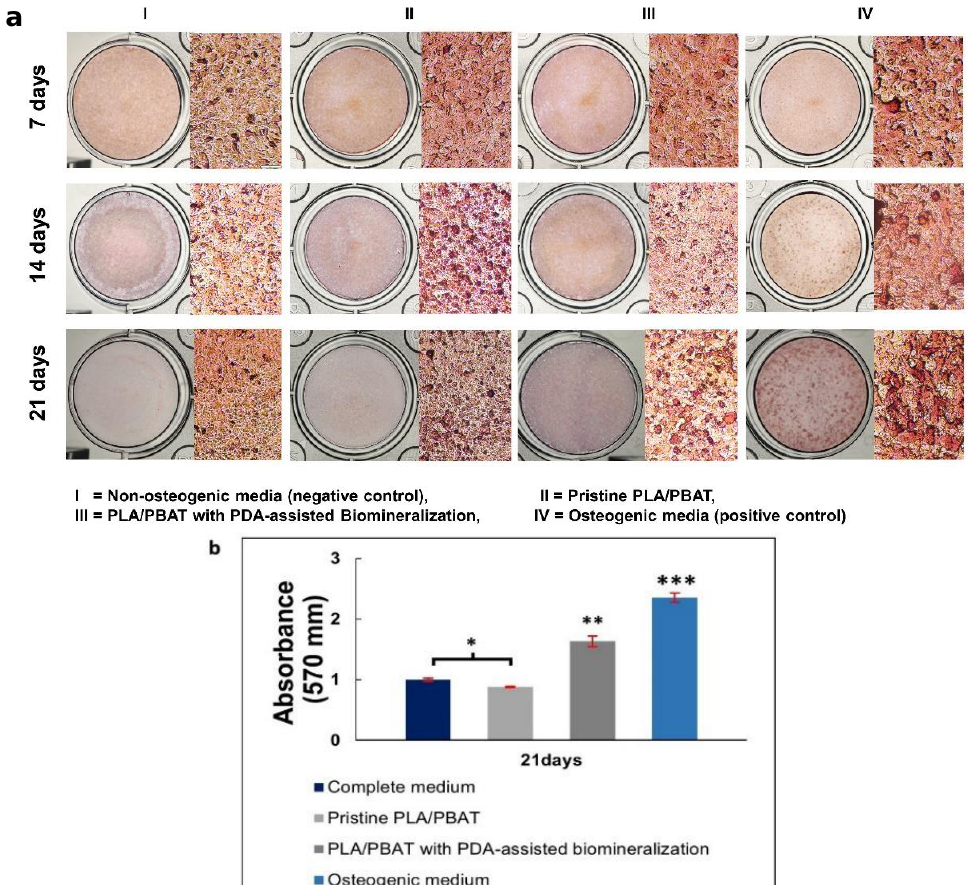
Figure 13. Mineralization assay with Alizarin Red S staining of MG-63 cells. Images of MG-63 cells cultured in the complete medium (negative control), extraction medium of pristine PLA/PBAT, extraction medium of PLA/PBAT with PDA-assisted biomineralization, and the osteogenic media (positive control) for 7, 14, and 21 days ( a ). Quantitative data of Alizarin Red S staining extraction after incubation for 21 days, expressed in the form of absorbance value at 570 nm ( b ). The different numbers of asterisks represent the statistical significance ( p ≤ 0.05).